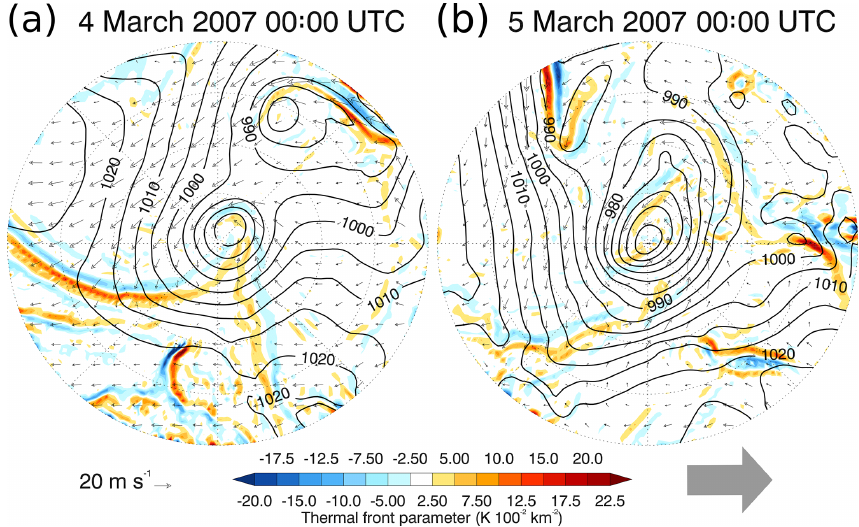
Figure 5. N1 cyclone-centered MSLP (solid black contours, 5hPa contour intervals), 925hPa system relative horizontal winds (20ms − 1 , ref- erence arrow), and 925hPa thermal front parameter (color, 2.5K100 − 2 km − 2 intervals) on (a) 4 March 2007 at 00:00UTC and (b) 5 March 2007 at 00:00UTC. Radial dotted lines are plotted every 45 ◦ and dotted circles represent 5, 10, 15, and 20 ◦ radii from cyclone center. The cyclone has been rotated in order that the direction of cyclone propagation is toward the right, indicated by the large grey arrow. NB: geographical north for (a) and (b) is toward the right of the